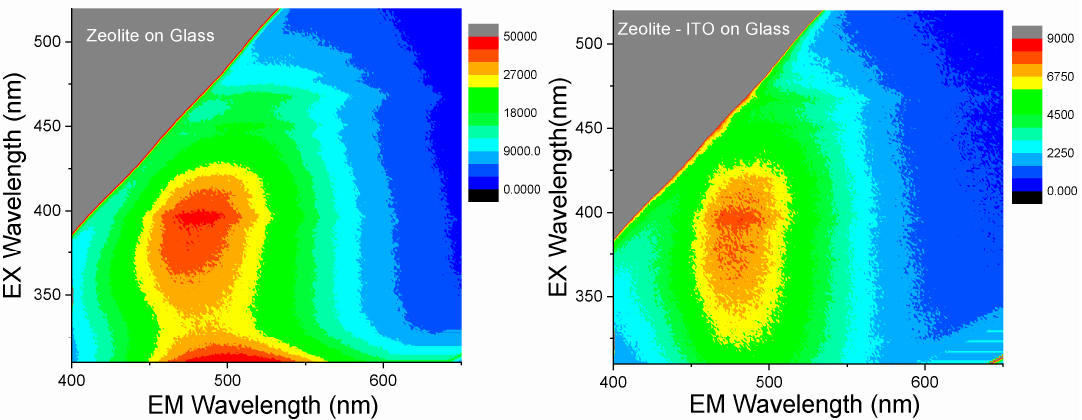
Figure 6. Excitation–emission two-dimensional plots for the zeolite 3A–carbon layers on glass and ITO/glass.